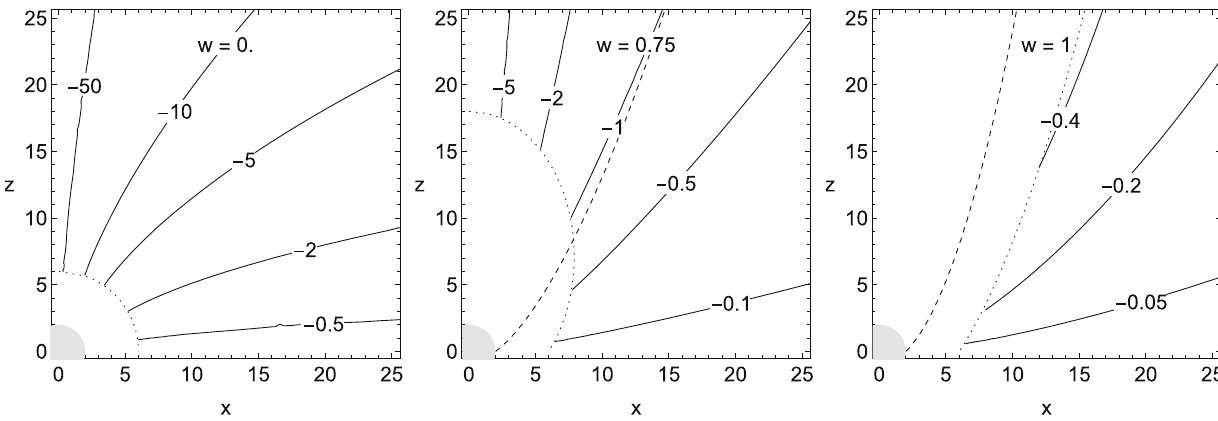
Fig. 3 For attracting LF ( B < 0), we plot the radial positions of stable circular orbits for charged particles in the off-equatorial plane. Differ- ent MF configurations w = 0 , 0 . 75 , 1 have been plotted. The grey disk shows the BH horizon, the numbers on each solid curve indicate the